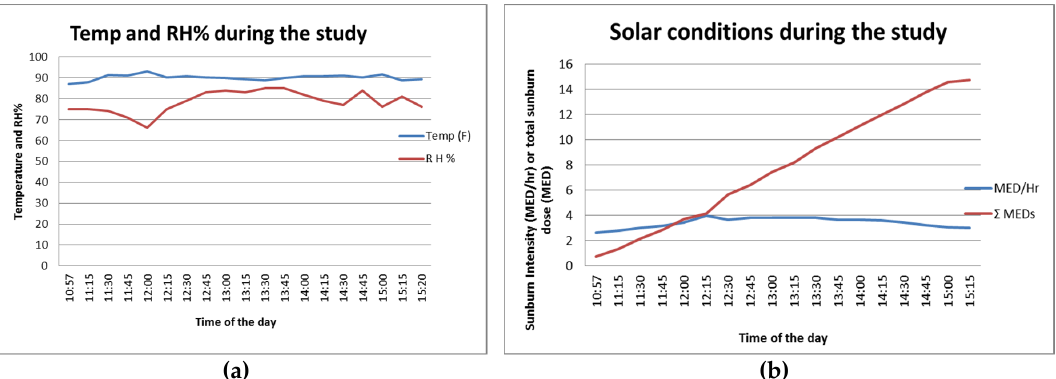
Figure 1. Environmental measures at beach. ( a ) Temperature and relative humidity during the study; ( b ) Solar conditions during the study. Blue line shows measured UV intensity (MED/h) and red line shows cumulative erythemal dose throughout the study. Table 1. Subjects’ sun exposure and water activity during the study. The brackets indicate measured ranges.